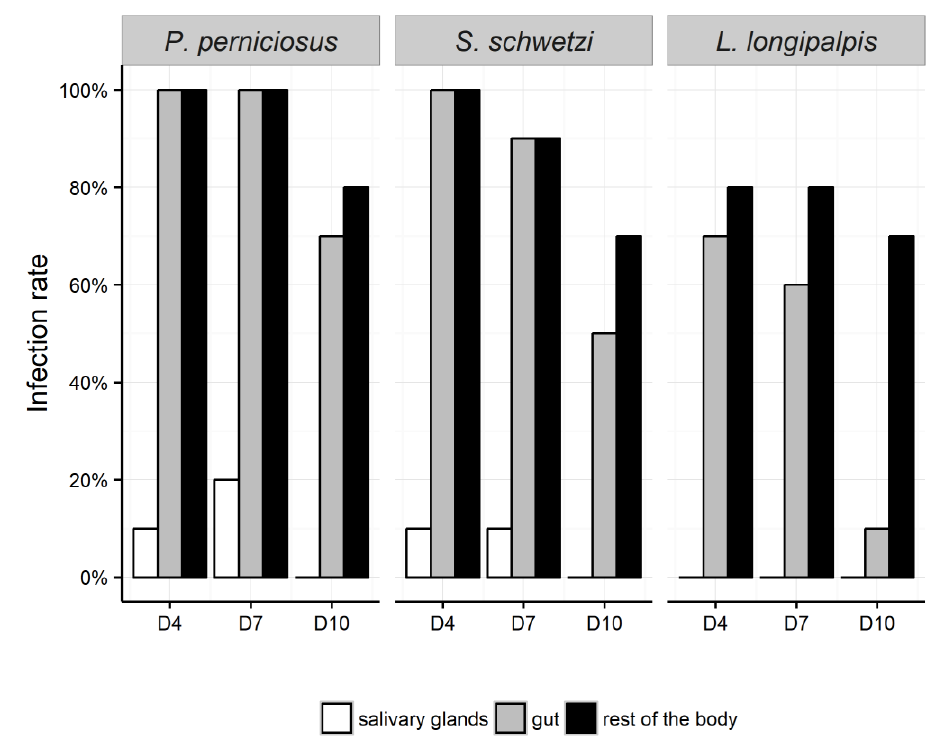
Figure 4. Tissue specifity and infection rate in Phlebotomus. perniciosus , Sergentomyia schwetzi, and Lutzomyia longipalpis .